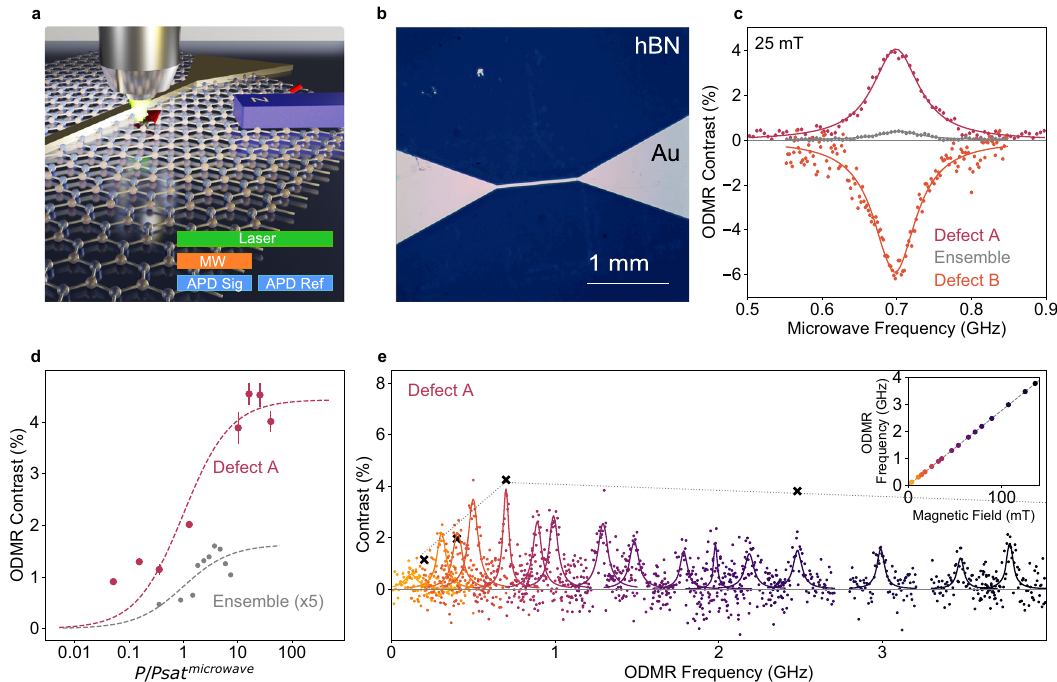
Fig. 2 Room-Temperature ODMR Setup and Saturated ODMR Measurements. a An illustration of the measurement setup showing a permanent fi xed magnet positioned in-plane relative to the hBN layers with lithographically patterned microstrip. Inset schematic representing one cycle of the ODMR protocol: a microwave pulse (orange) for the fi rst half of the lock-in cycle, and signal and reference counts that are measured by the single-photon counting detectors (APD) (blue). The excitation laser is present for the full lock-in cycle (green). b An optical image of a lithographically patterned 1-mm-long gold microstrip used to apply microwave fi eld to the hBN defects. c Room-temperature saturated ODMR of single defects (defect A, red circles; defect B, orange circles) and of the ensemble (grey circles), all measured at 25-mT external in-plane magnetic fi eld and at 10 times the microwave saturation